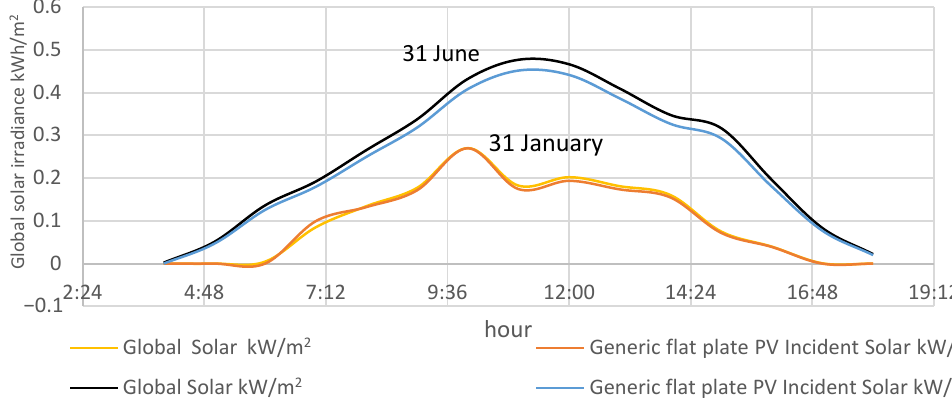
Figure 6. Global solar irradiance curve for two days, 30 June and 31 January (2007).